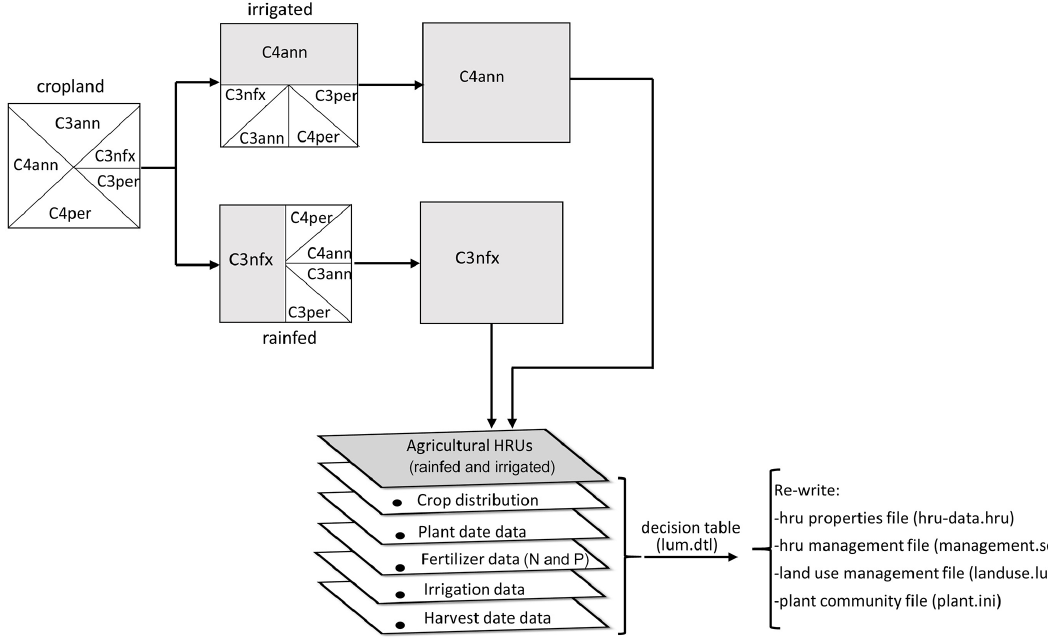
Figure 2. Workflow for incorporating crop phenology and crop management data from global datasets into the model.